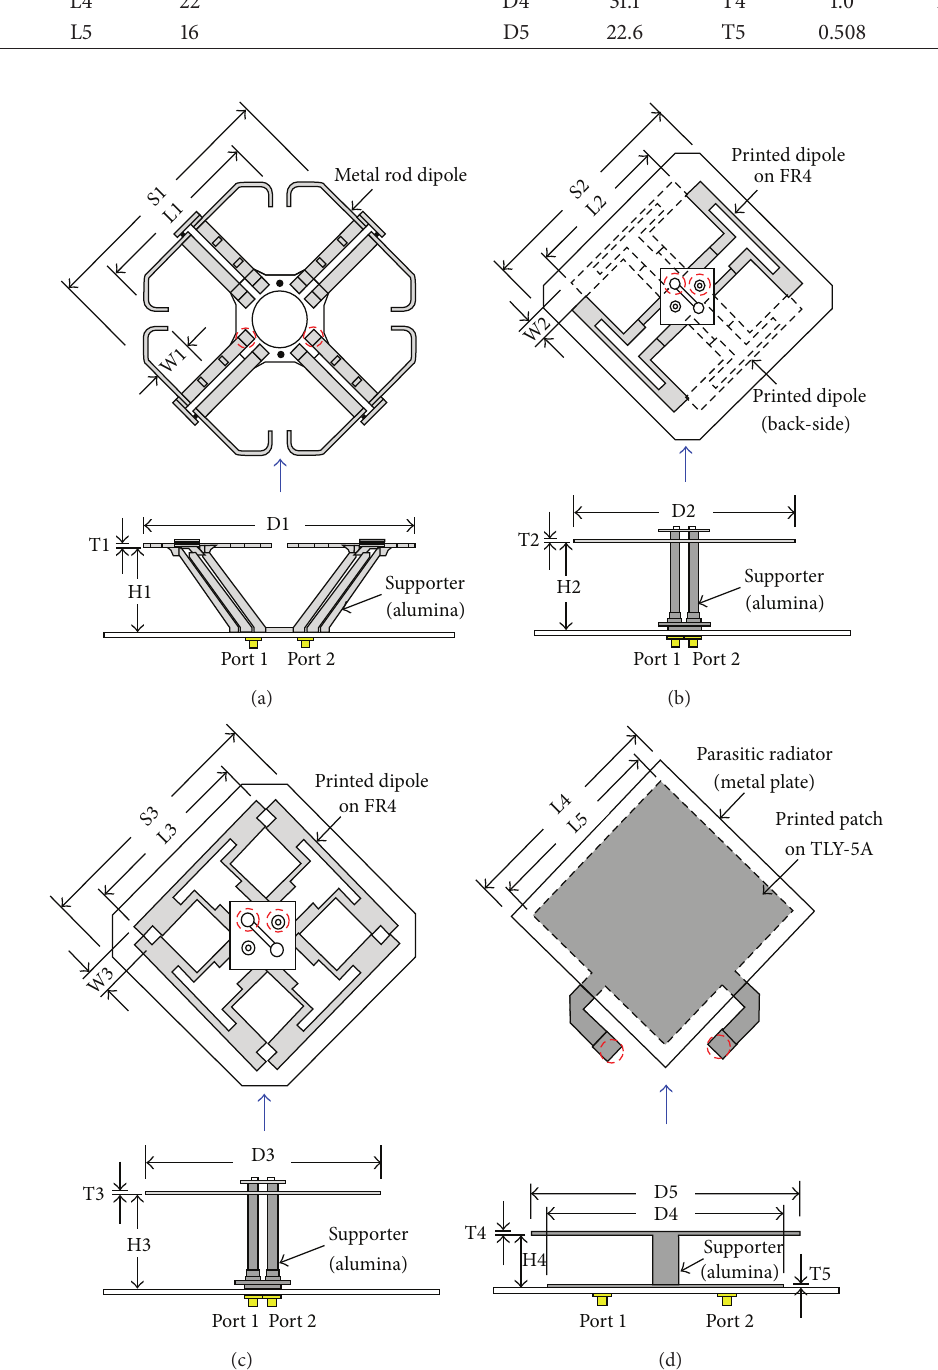
Figure 1: Single band radiator structure: (a) Band 1, (b) Band 2, (c) Band 3, and (d) Band 4 (up: top view, down: side view, and large arrow: direction of side